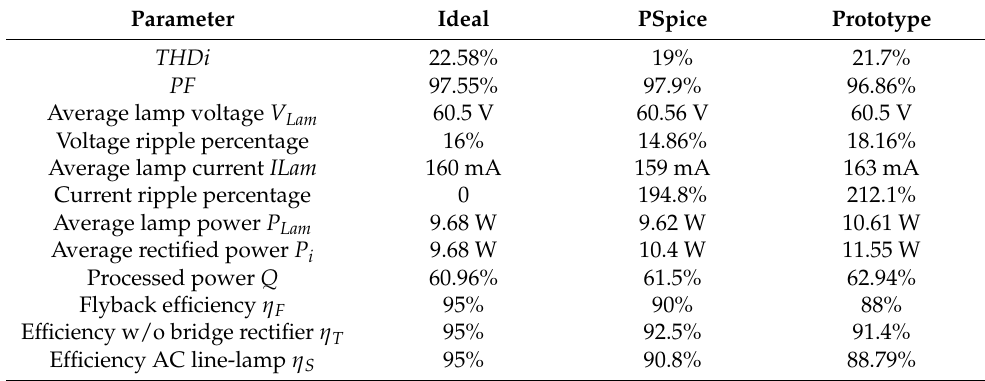
Table 5. Summary of results of the